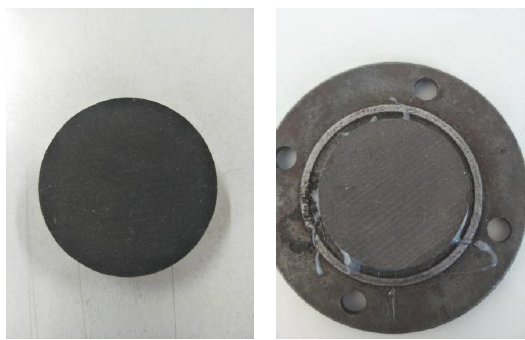
Figure 5: Aluminum-based diamond composite before